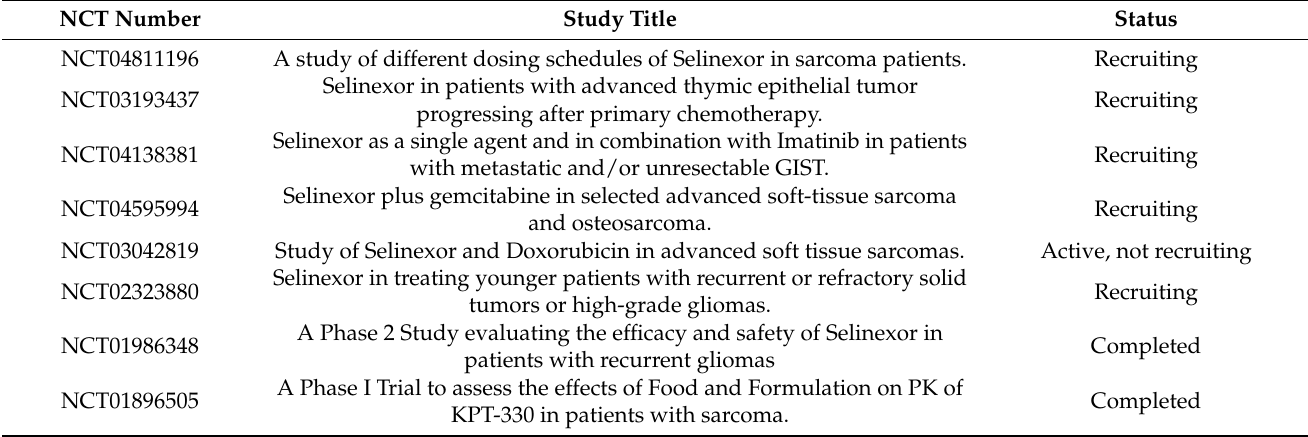
Table 2. List of registered clinical trials involving Selinexor in various rare